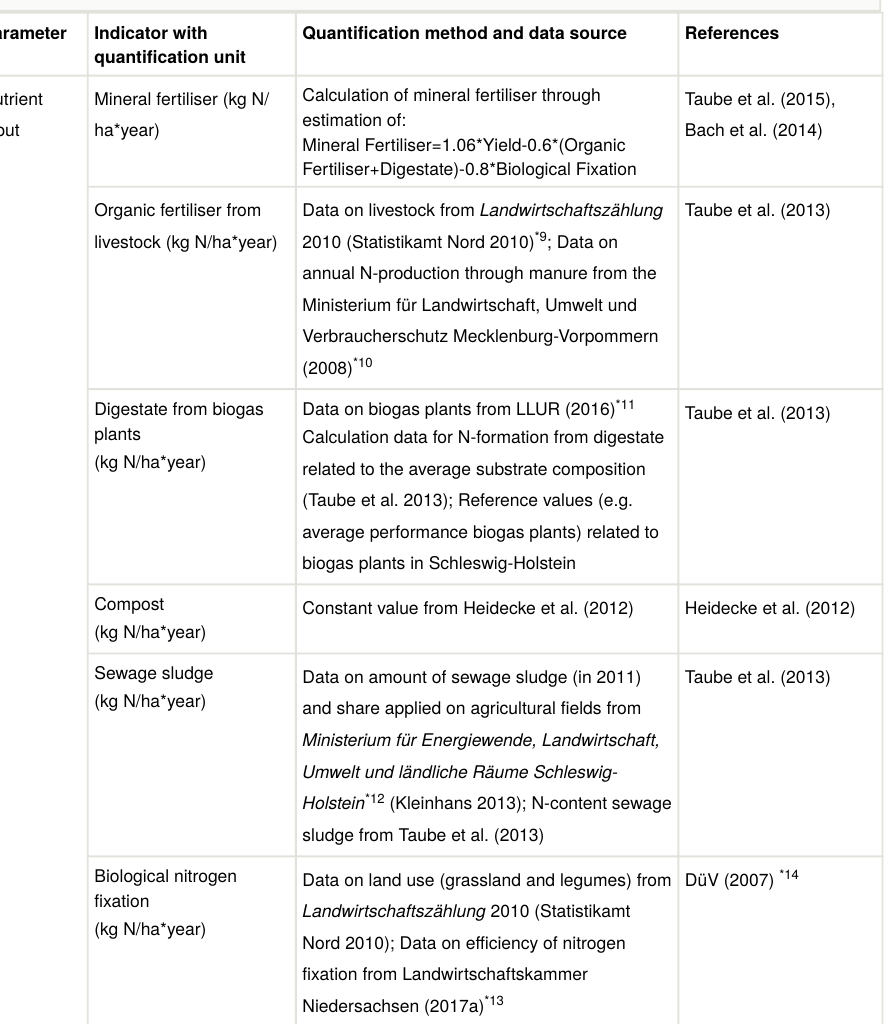
Overview on methodologies and data sources used for the parameters of the nitrogen Parameter